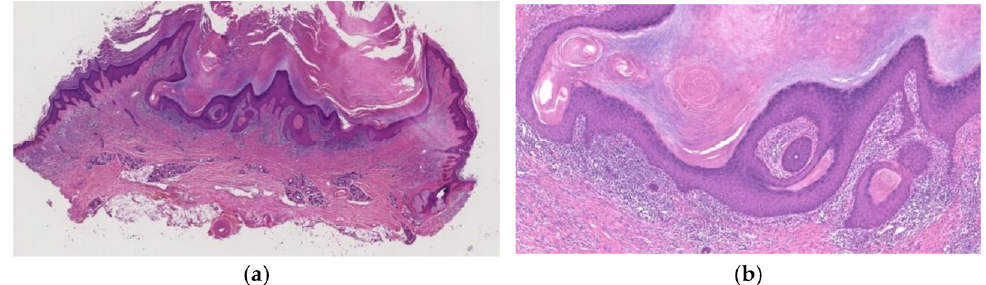
Figure 5. Histopathological findings of KA at the regressed stage. A depressed epidermal lesion with overhanging and rising edges is observed ( a ), and the epidermis is flattened and atrophic with loss of rete ridges ( b